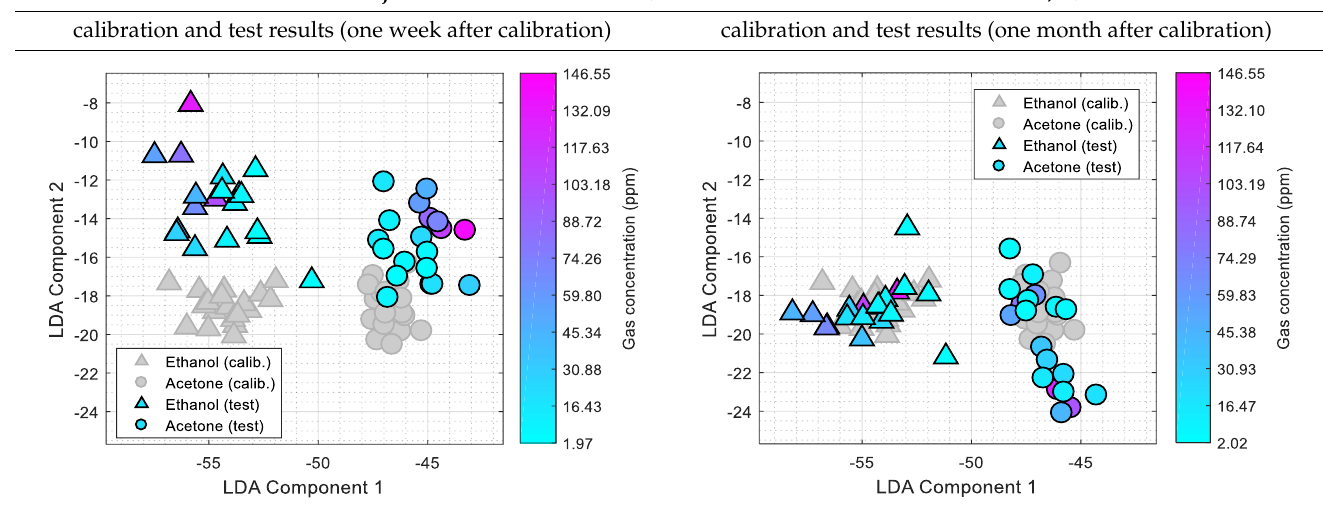
Table 7. Calibration data of ethanol (triangle, gray) and acetone (circle, gray) are represented using the LDA projection obtained from this calibration data. Comparative projection of additional test data of ethanol (triangle, colored) and acetone (circle, colored) obtained one week (left column) and one month (right column) after the calibration. The absolute concentration of the volatiles measured during the tests is depicted with the attached color-map scale. The data represented is the same previously shown in Table